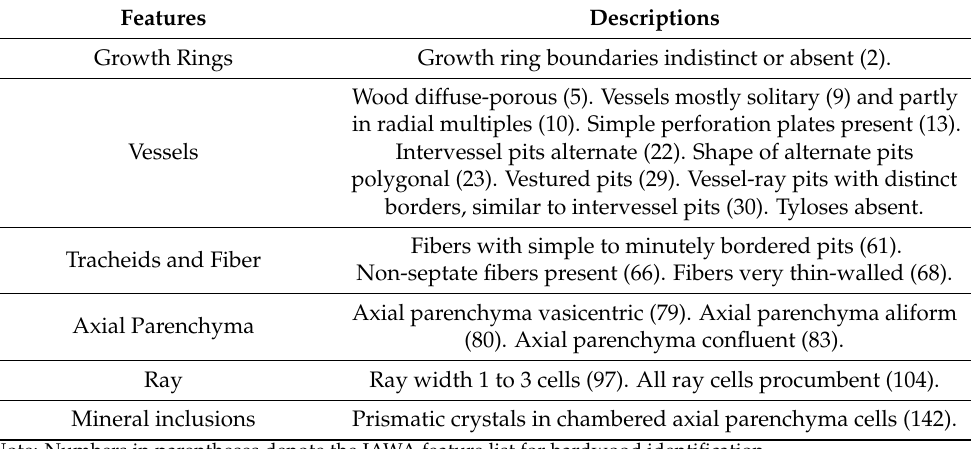
Table 2. Qualitative anatomical characteristics of both Acacia mangium and Acacia hybrid based on the International Association of Wood Anatomists (IAWA) feature list.